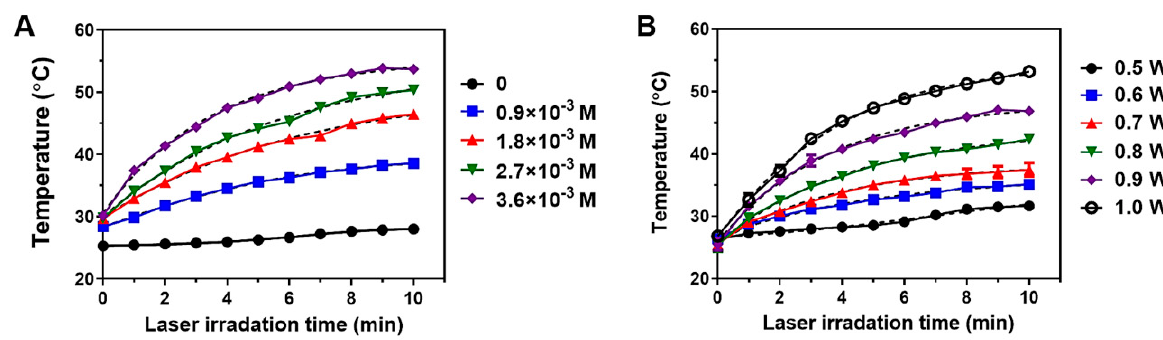
Figure 6. Photothermal activity of BSA-Silver NPs. Temperature profiles of BSA-Silver NPs after laser irradiation at ( A ) 1 W with varying sample concentrations (0–3.6 × 10 − 3 M as silver) and ( B ) at 2.7 × 10 − 3 M with varying laser powers (0.5–1.0 W). Dotted lines are showing the non-linear regression fitted curves of the original data curves. (BSA-Silver NPs: BSA-coated silver nanoparticles).